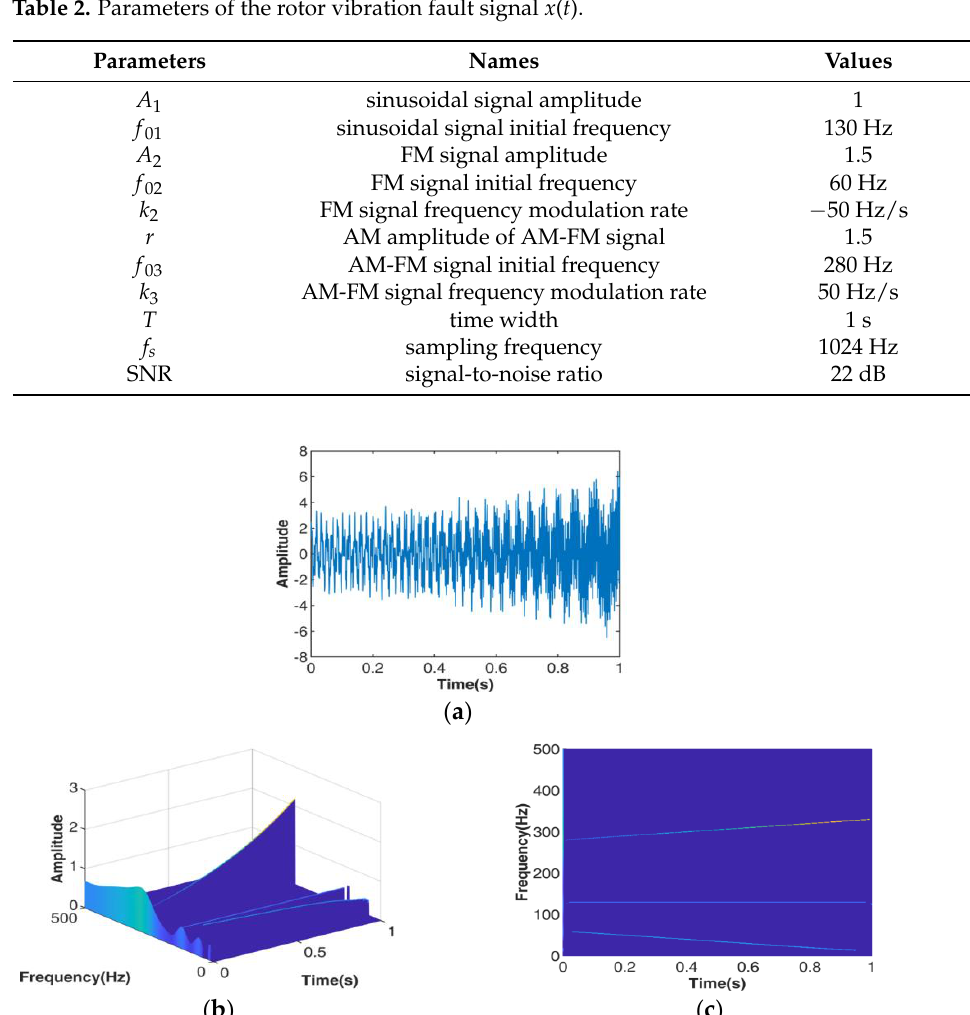
Table 2. Parameters of the rotor vibration fault signal x ( t ).